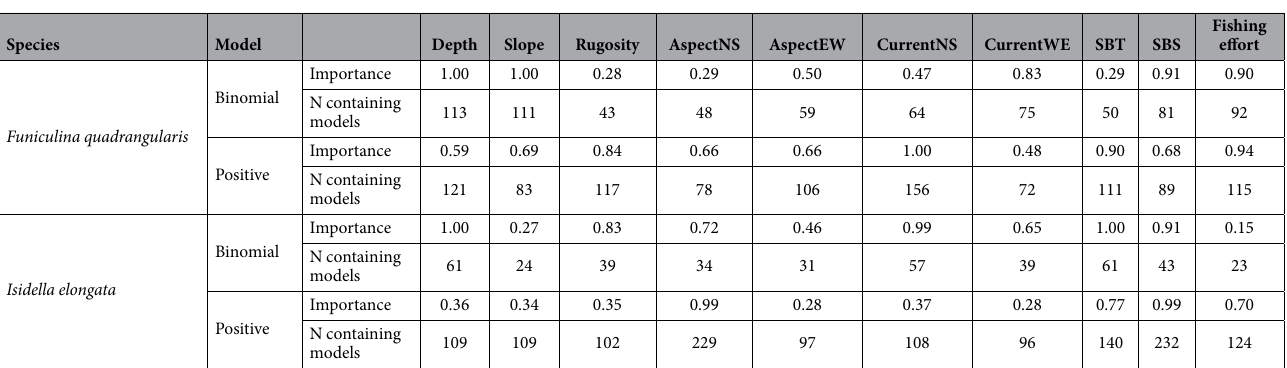
Table 5. Relative importance of predictor variables (calculated as the sum AIC weights from models that contain that variable within the 95% confidence interval) for Funiculina quadrangularis and Isidella elongata